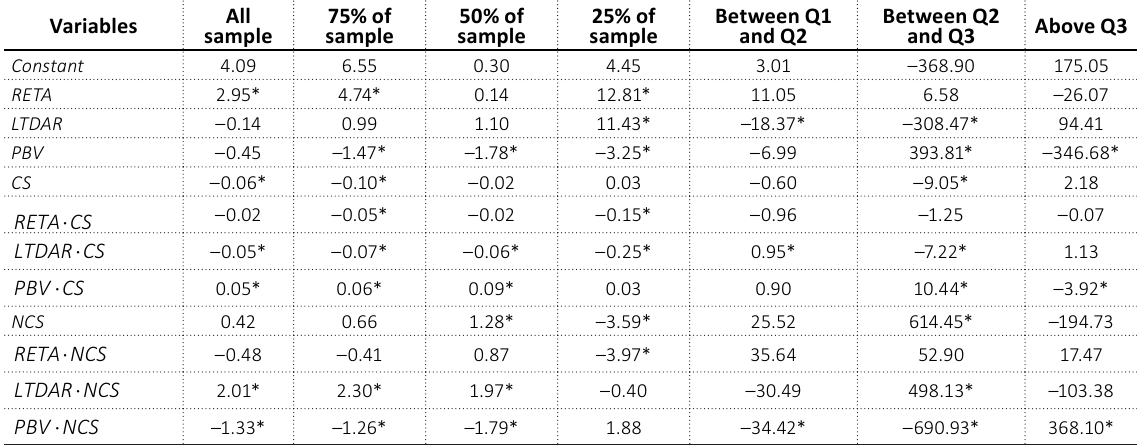
Table 3. Dividend policy on controlling and non-controlling shareholders